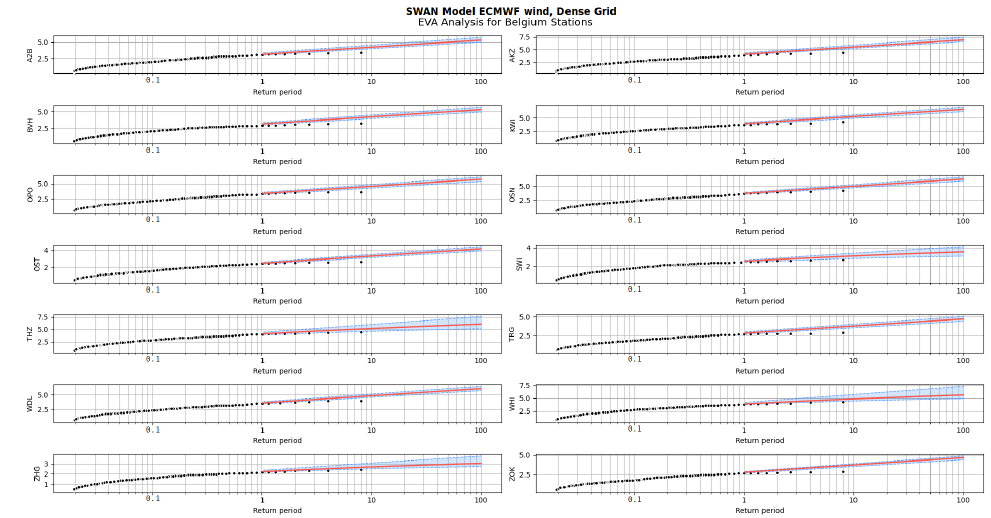
Figure 14. Linearised General Extreme Value Analysis plots for calculated significant wave height vs. return period (years) for the ECMWF-ERA5 forced calibrated SWAN modelled significant wave heights at various Belgian stations computed on the 2.5 km